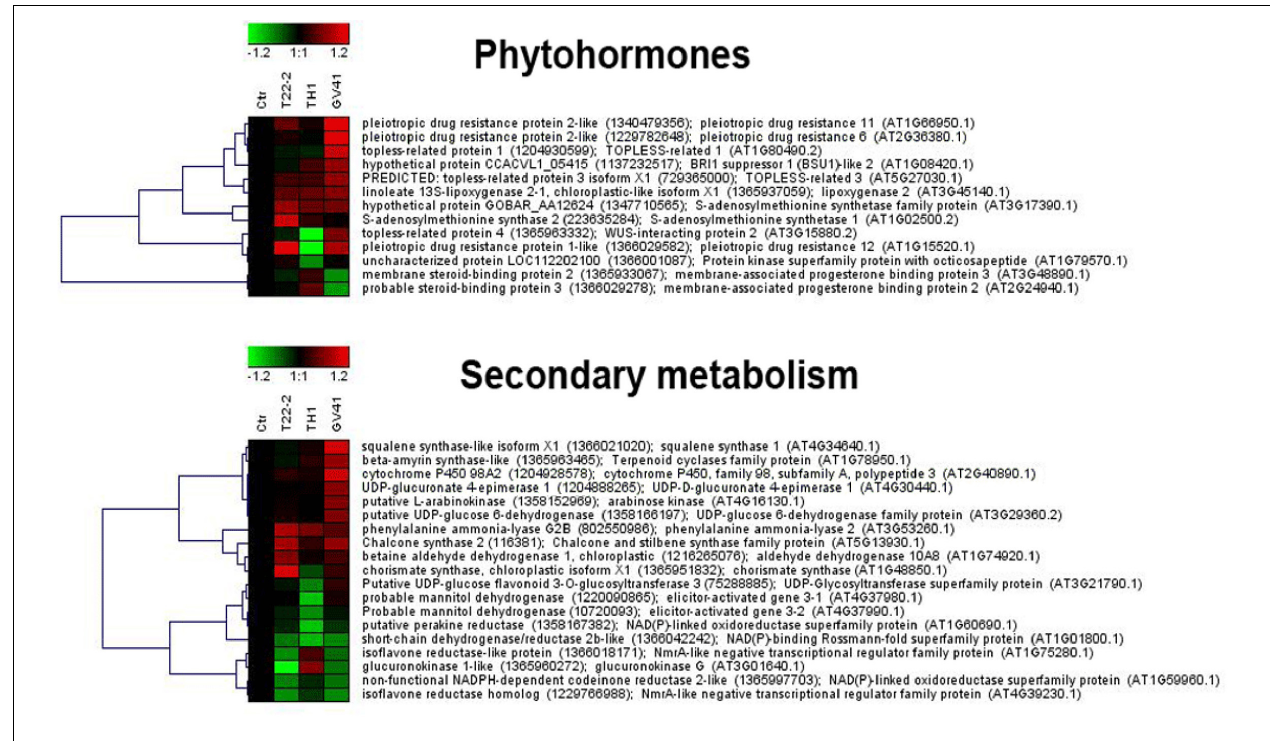
FIGURE 4 | Heat-map representation and hierarchical clustering analysis of proteins related to phytohormone metabolism (upper panel) and secondary metabolism (lower panel) , which were differentially represented in strawberry fruits produced by plants subjected to the treatments with Trichoderma strains (T22, TH1, and GV41), as compared to control (CTR). Proteins shown are those with abundance fold changes ≥ 1.50 or ≤ 0.66 compared to control ( P ≤ 0.05) ( Supplementary Table S3 ). Data are reported as log 2 transformed abundance ratio values. Hierarchical clustering analysis of DRPs was performed using Genesis 1.8.1